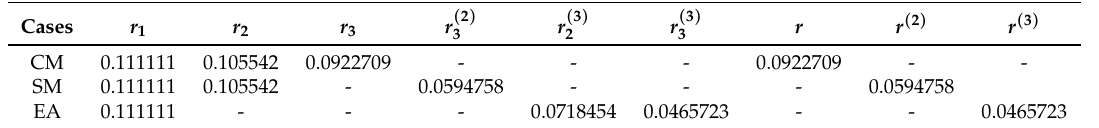
Table 5. Radii of convergence for Example